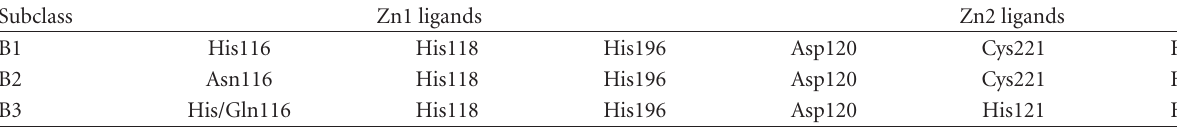
Table 1: The zinc ligands in class B β